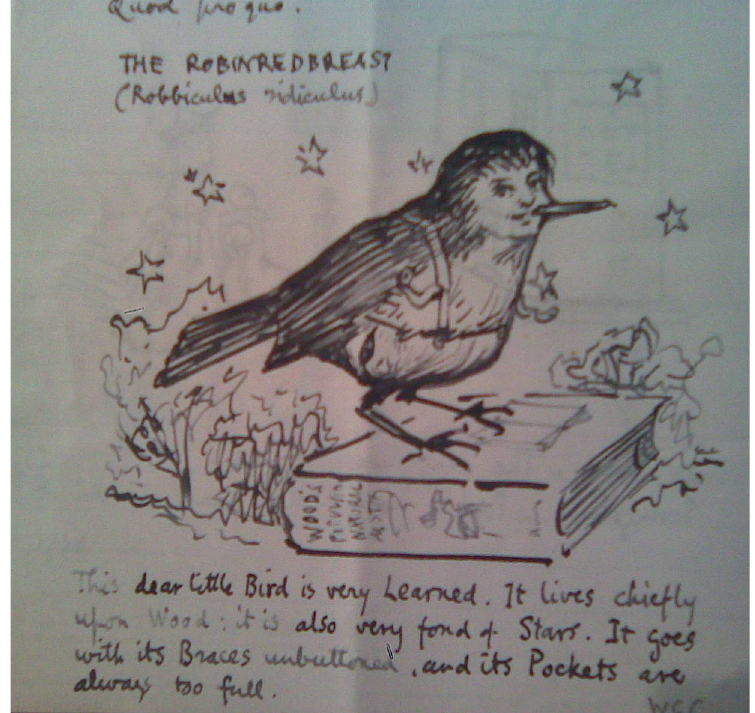
Figure 2. The Roboyredbreast, from Nothing Much (1897) (Courtesy of Abbot Hall, Kendal).